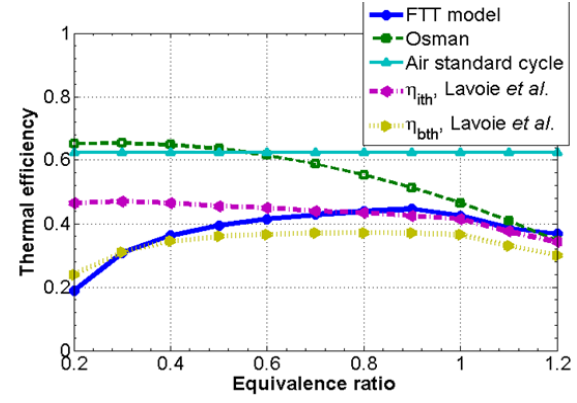
Figure 6. Variation of thermal efficiency with the fuel-air equivalence ratio and engine speed using various models. Comparison of the results obtained for the power developed by the engine using the FTT Model and with the other